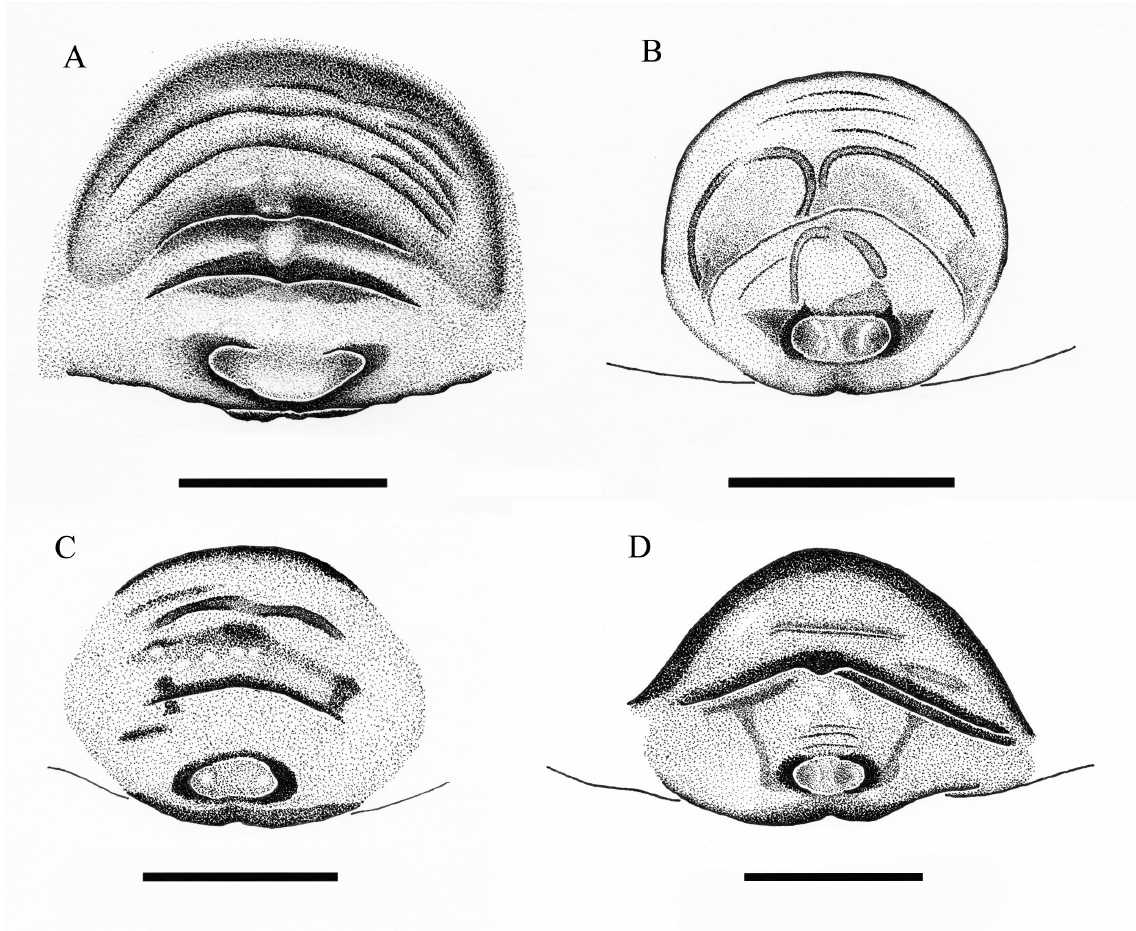
Fig. 8. Epigynes of Uroctea grossa Roewer, 1960; ventral view. A . Holotype, ♀ (GNM-A497). B . ♀ from Mazandaran Province, Larijan (MHNG). C . ♀ from Sistan and Baluchistan Province, surroundings of Taftan volcano (MHNG). D . ♀ from Turkmenistan (SMF38817). Scale bars = 0.5